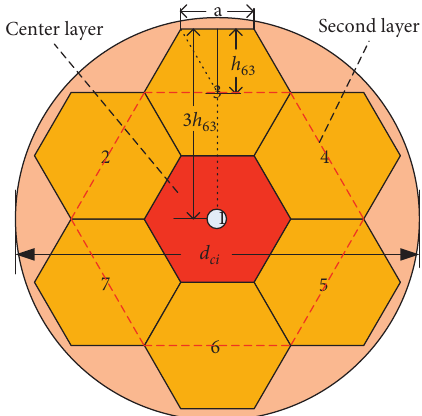
Figure 3: Two-layer hypernetwork of new acoustic